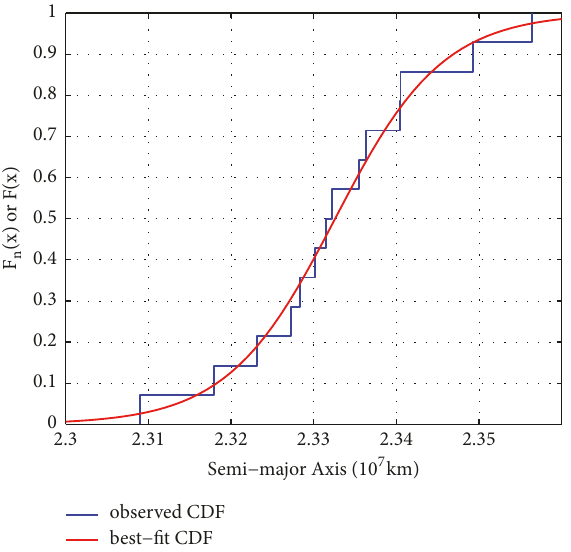
Figure 10: Comparison of the observed CDF and the best-fit CDF of semi-major